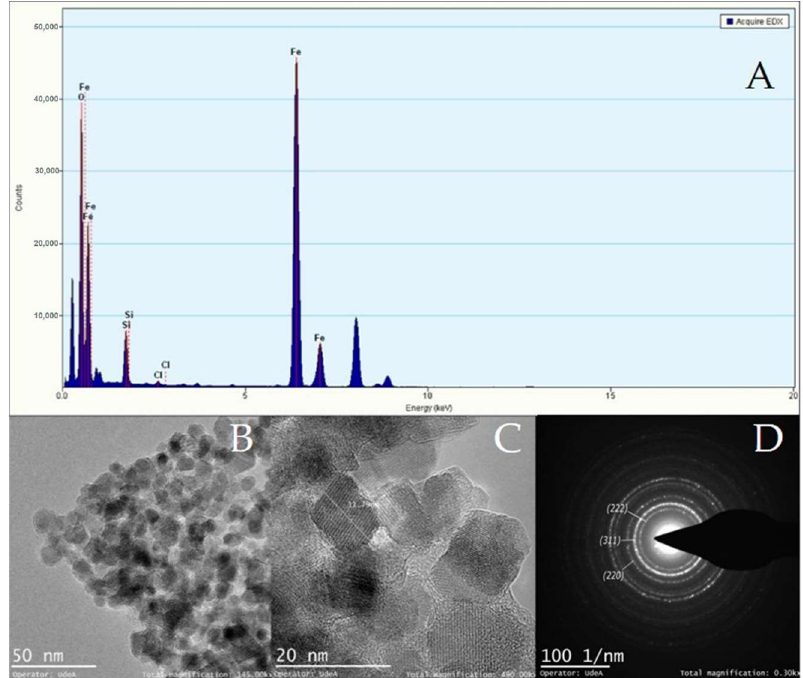
Figure 11. TEM−EDX analysis of magnetite particles manufactured by the 3DB micromixer. ( A ) El- emental analysis confirmed the abundance of iron. ( B ) Low magnification imaging confirmed the typical morphology of magnetite crystals. ( C ) High magnification imaging allowed the calculation of an average particle diameter of 12.70 ± 2.8 nm. ( D ) Selected area electron diffraction with indexed planes that correspond to magnetite crystalline planes.